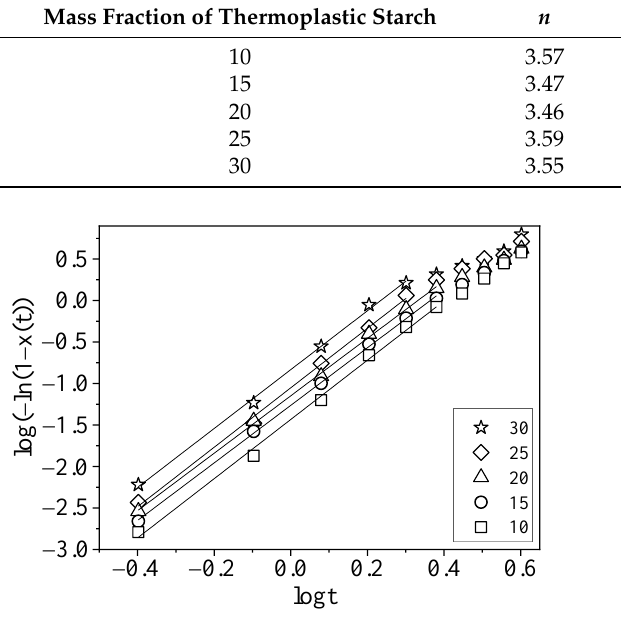
Table 3. The kinetics parameters of the fitting of the primary crystallization. Mass Fraction of Thermoplastic Starch